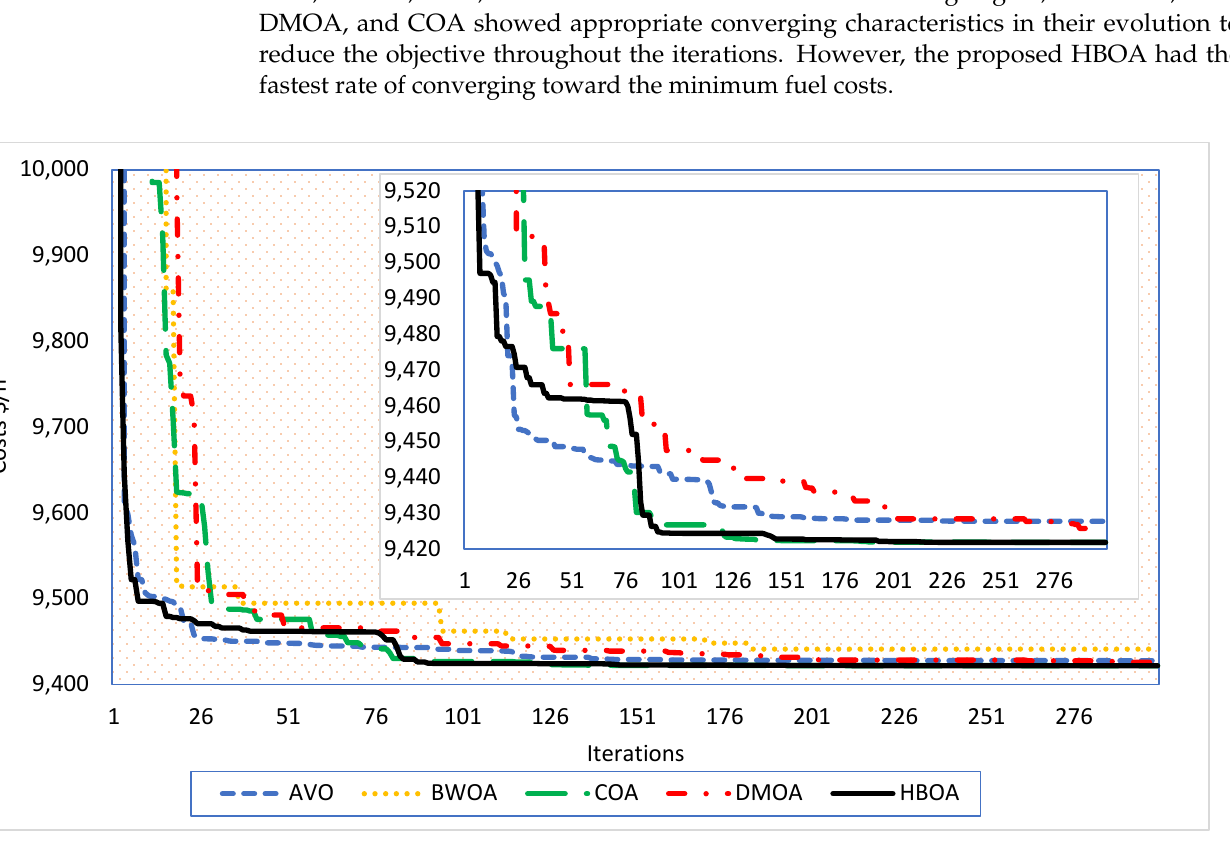
Figure 4. Convergence rates of the proposed HBOA and the AVO, DMOA, COA, and BWOA of Case 1 for the second